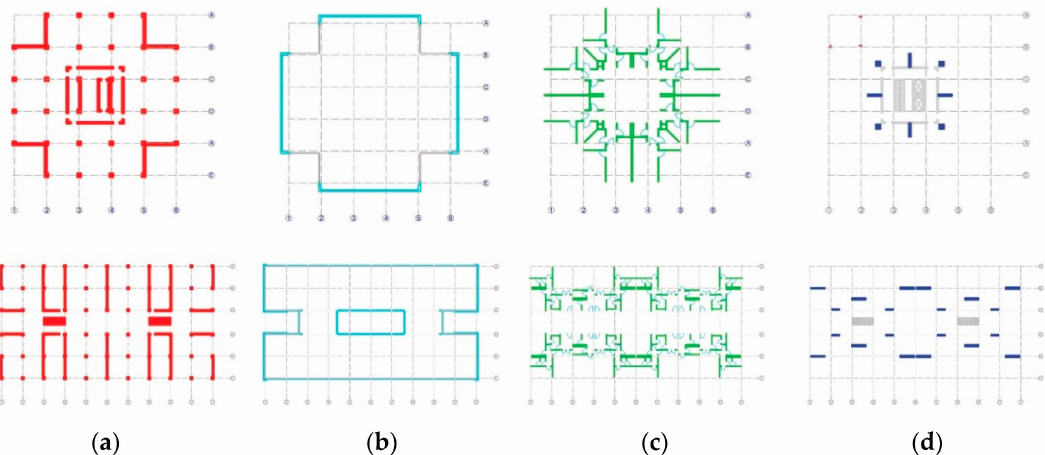
Figure 8. Block No. 1—Decompositions of IMS Building Model for Building No. 1 and Building No. 2: